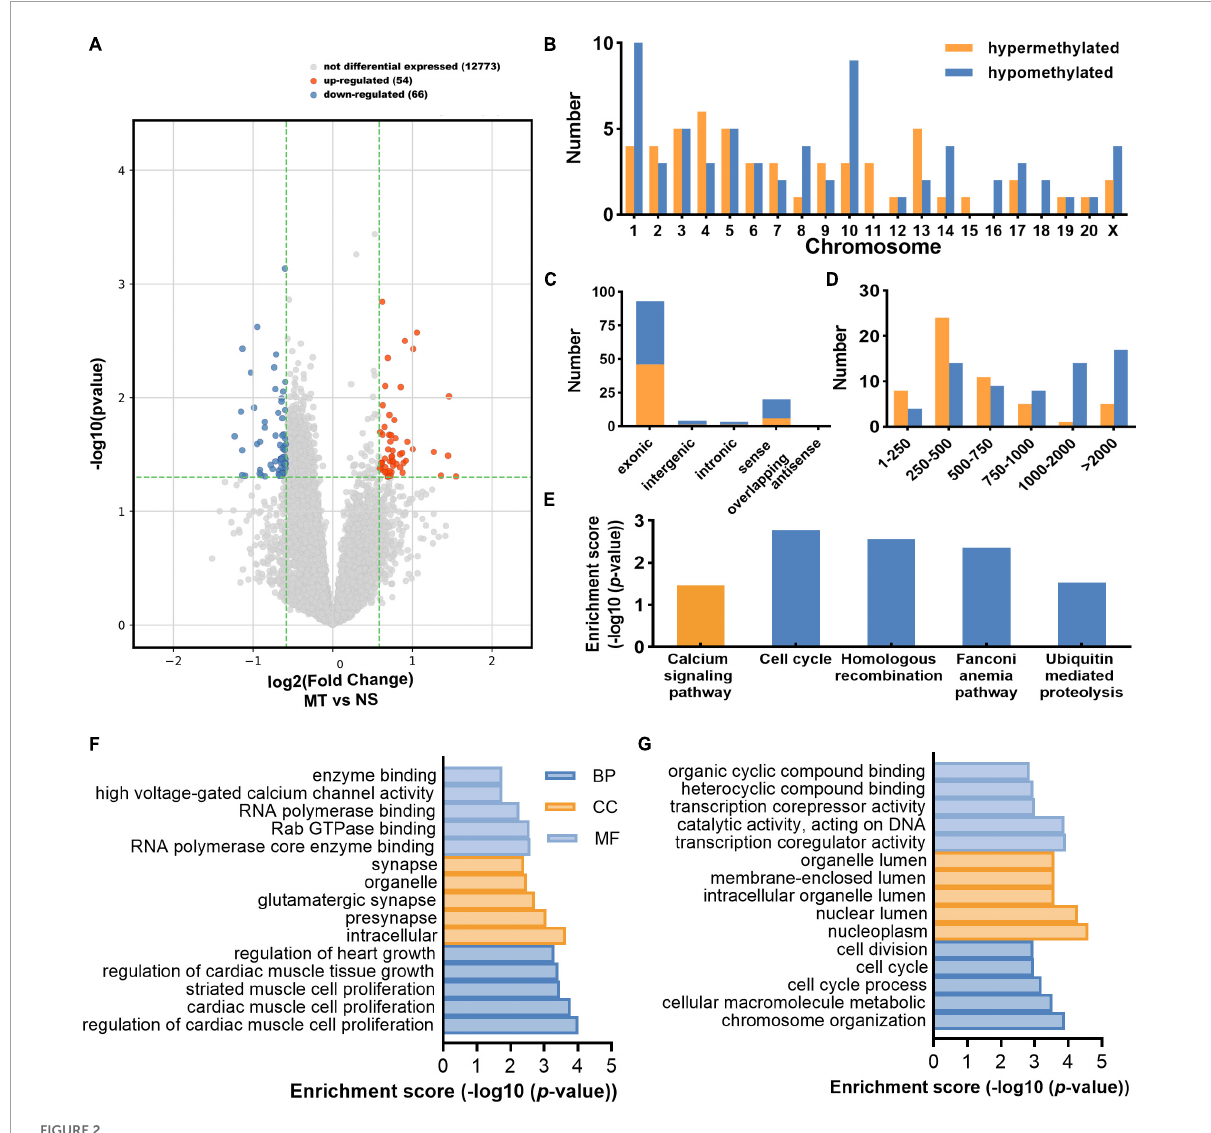
FIGURE2 Distribution of differentially methylated circRNAs. (A) The volcano plot shows the distribution of differentially methylated circRNAs (Fold change ≥ 1.5 and P < 0.05) between the MT group and the NS group. (B) The chromosome’s origins for host genes of differentially m 6 A-methylated circRNAs. (C) The genomic origins of differentially m 6 A-methylated circRNAs. (D) The length distribution of differentially m 6 A-methylated circRNAs. (E) The enriched pathways of the host gene of the differentially m 6 A-methylated circRNAs through KEGG analyses. (F) The top 15 enriched GO terms of the host gene of the hypermethylated circRNAs. GO terms include biological process (BP) analysis, cellular component (CC) analysis, and molecular function (MF) analysis. (G) The top 15 enriched GO terms of the host gene of the hypomethylated